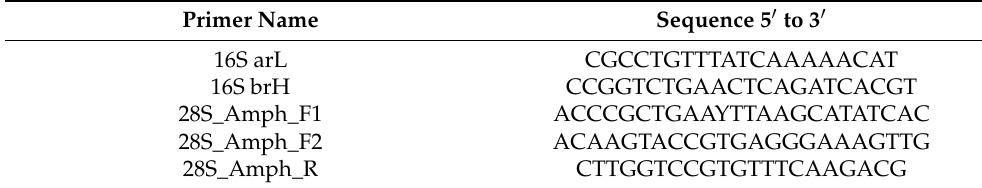
Table 2. Sequences of primers used for DNA